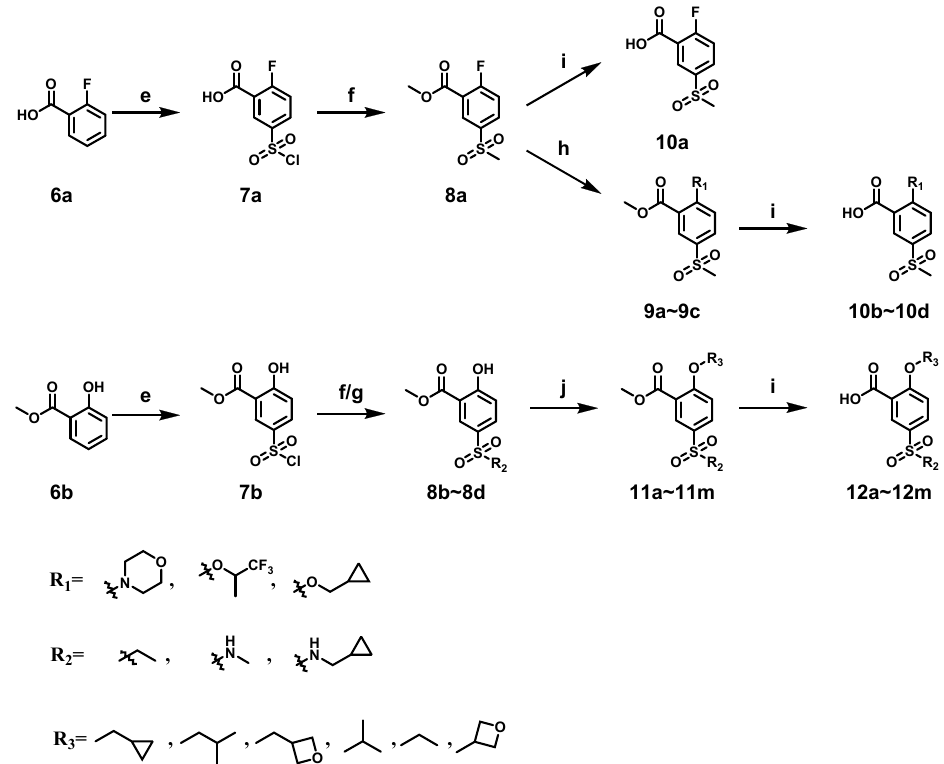
R 3 = Scheme 2. Synthesis of benzoic acid intermediates. Reagents and conditions: ( e ) HClSO 3 , 40 °C, 30 min; ( f ) i. Na 2 SO 3 , H 2 SO 4 , H 2 O, r.t., 2 h; ii. iodide alkanes, K 2 CO 3 , DMF, r.t., 3 h; ( g ) amine, DCM, r.t.,